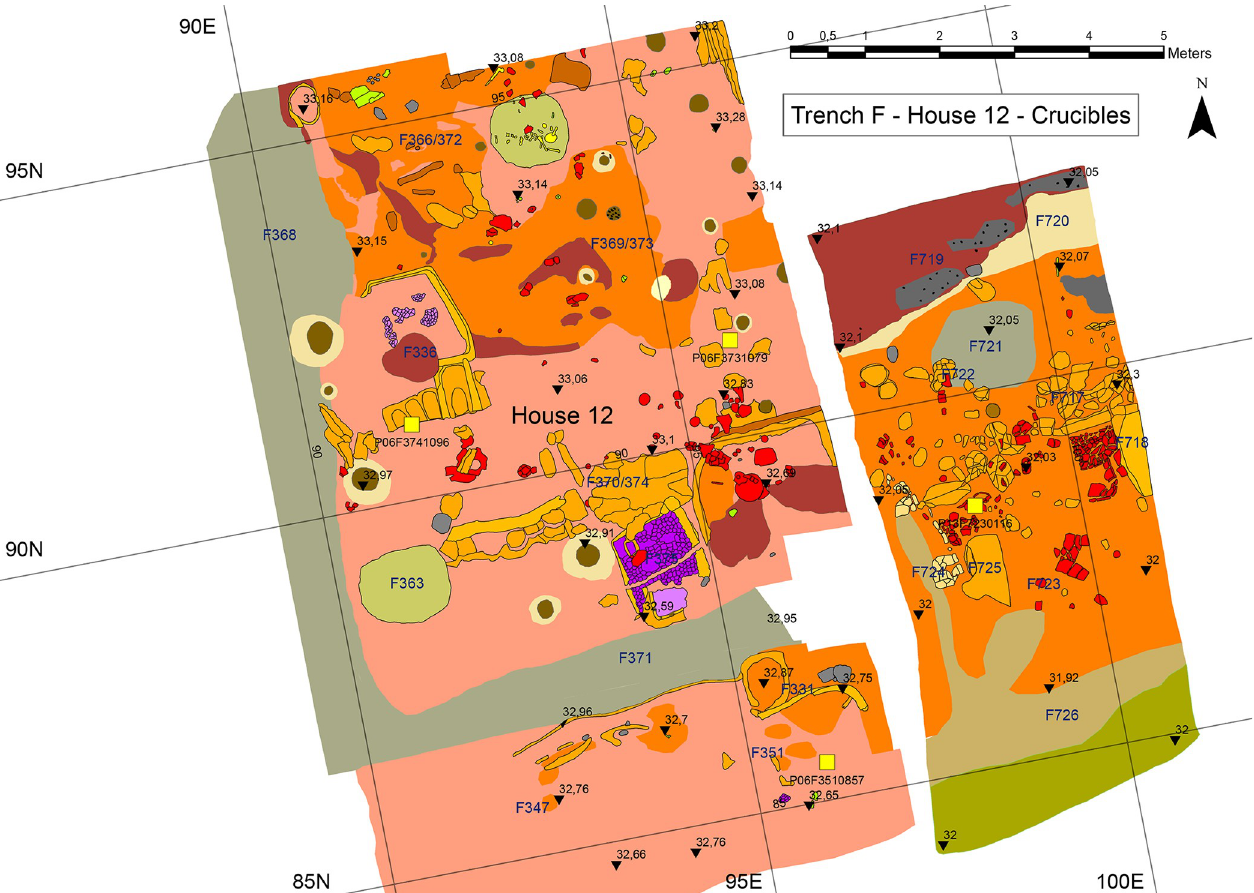
Fig 7. Plan of the context of the three crucibles in the two-storey house (Digital plan O. Joumarin).